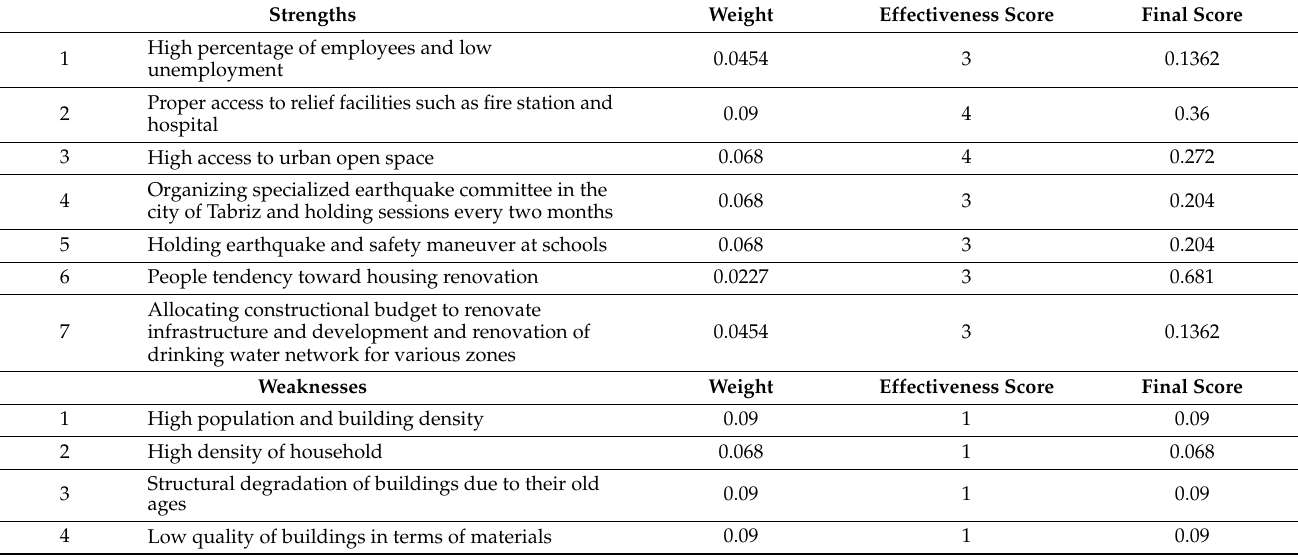
Table 16. Internal Factor Evaluation